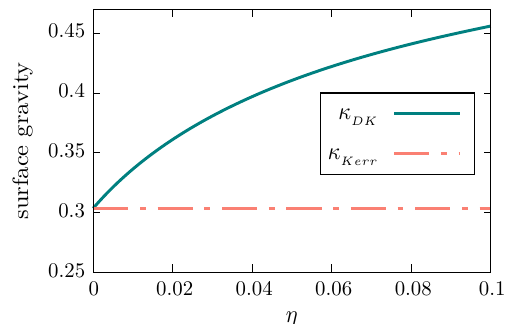
Fig. 6 Angular velocity of the horizon is shown for a = 0 . 45, and in a r s = 1. We retrieve the kerr case for η = 0 limit, which is shown as the H , is plotted with respect to η . DK curve constant along x